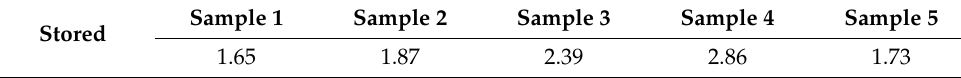
Table 2. Hermeticity tests ( × 10 − 4 Pa · cm 3